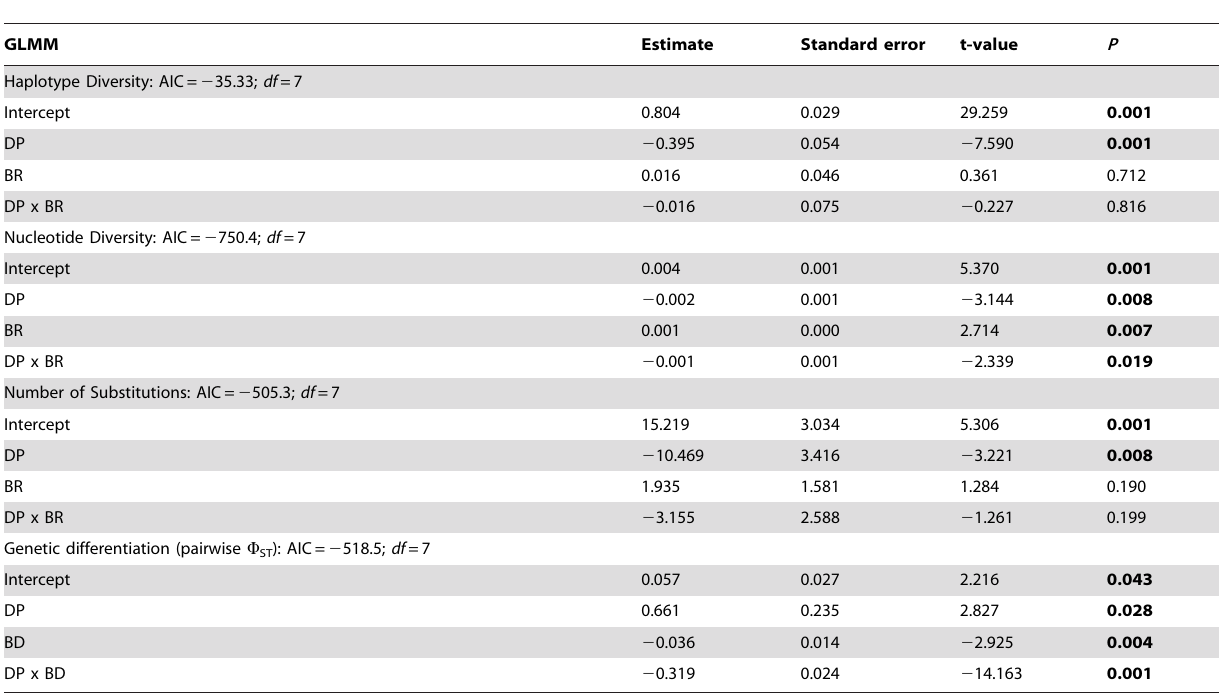
Table 3. GLMMs performed to compare genetic structure in species with high and low dispersal potential and biogeographic regions (north and south of 30 u S), with respect to haplotype diversity, nucleotide diversity, number of substitutions, and genetic differentiation (global W ST